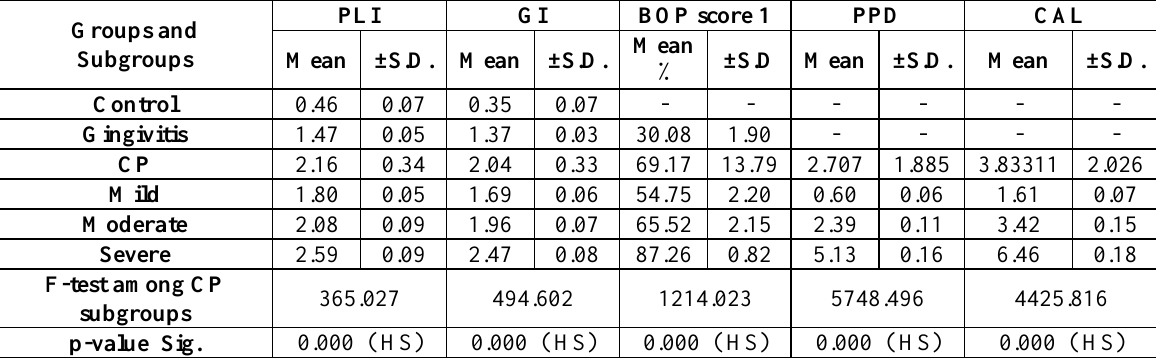
Table 1: Descriptive statistics of clinical periodontal parameters for groups and subgroups with difference among CP subgroups